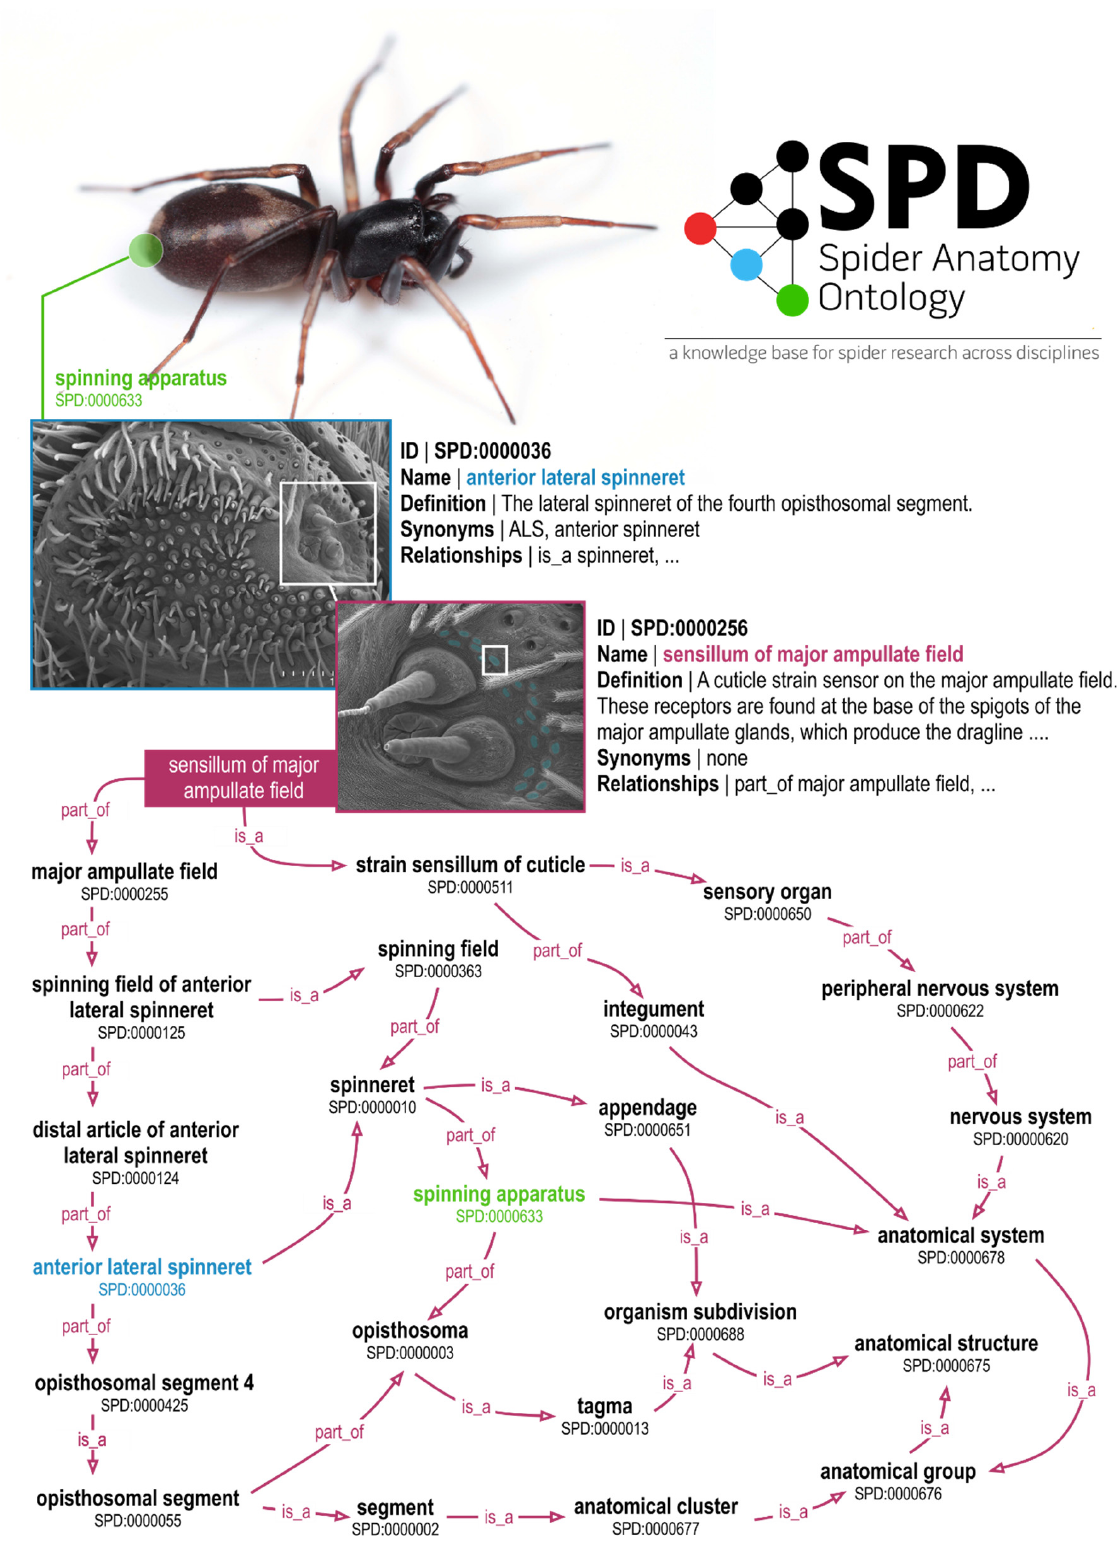
Figure 1. The Spider Anatomy Ontology (SPD) at a glance showing examples for individual entries (SPD:0000036 and SPD:0000256) as well demonstrating the relationships (‘is a’ and ‘part of’) between